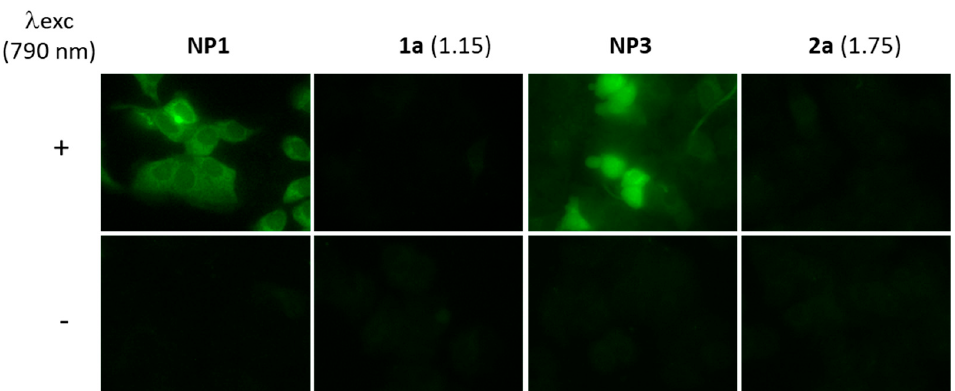
Figure 5. Reactive oxygen species (ROS) detection. MCF-7 cancer cells were incubated with NP1 or equivalent concentration of 1a , or NP3 or equivalent concentration of 2a for 24 h. Then DCF-DA was added. After 45 min, cells were irradiated under TPE ( λ exc = 790 nm), rinsed and imaged using fluorescent microscope EVOS M5000 (Thermofisher).